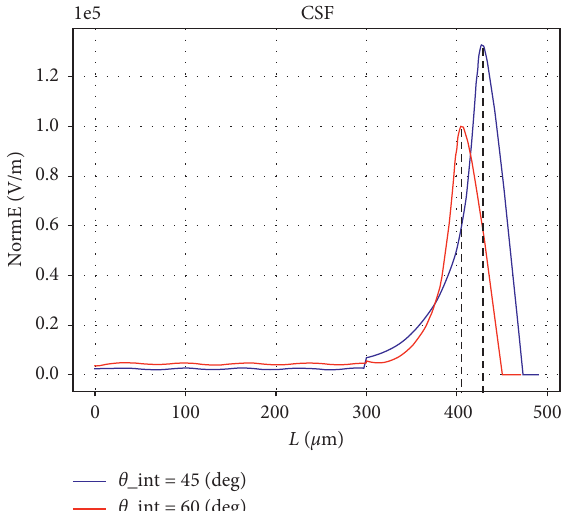
Figure 10: Electric field normE perpendicular to the surface of the periodic structure at different incident angles when the biological sample is CSF; L is the total thickness of the prism layer, sample layer, and metal layer.